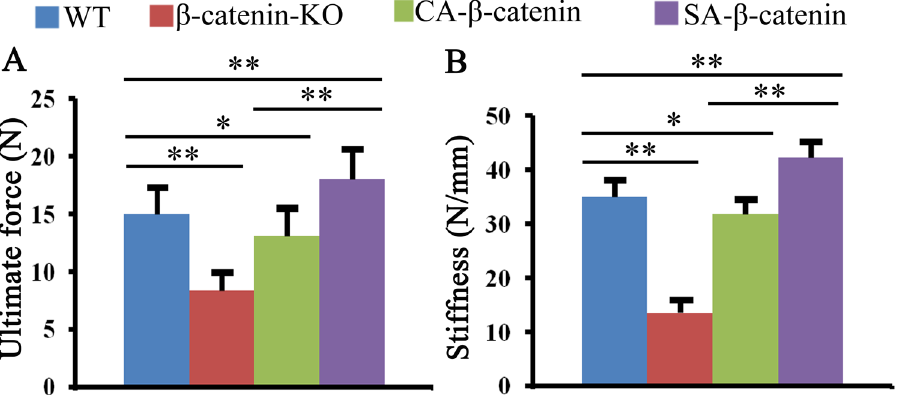
Figure 5. Mechanical test revealed that better bone fracture healing quality was obtained in SA- β -catenin mice. The ultimate load ( A ) and stiffness ( B ) of tibia fracture calluses in WT, β -catenin-KO, CA- β -catenin mice and SA- β -catenin mice. The values are expressed as the means ± SDs. * p < 0.05, ** p < 0.01 (n =